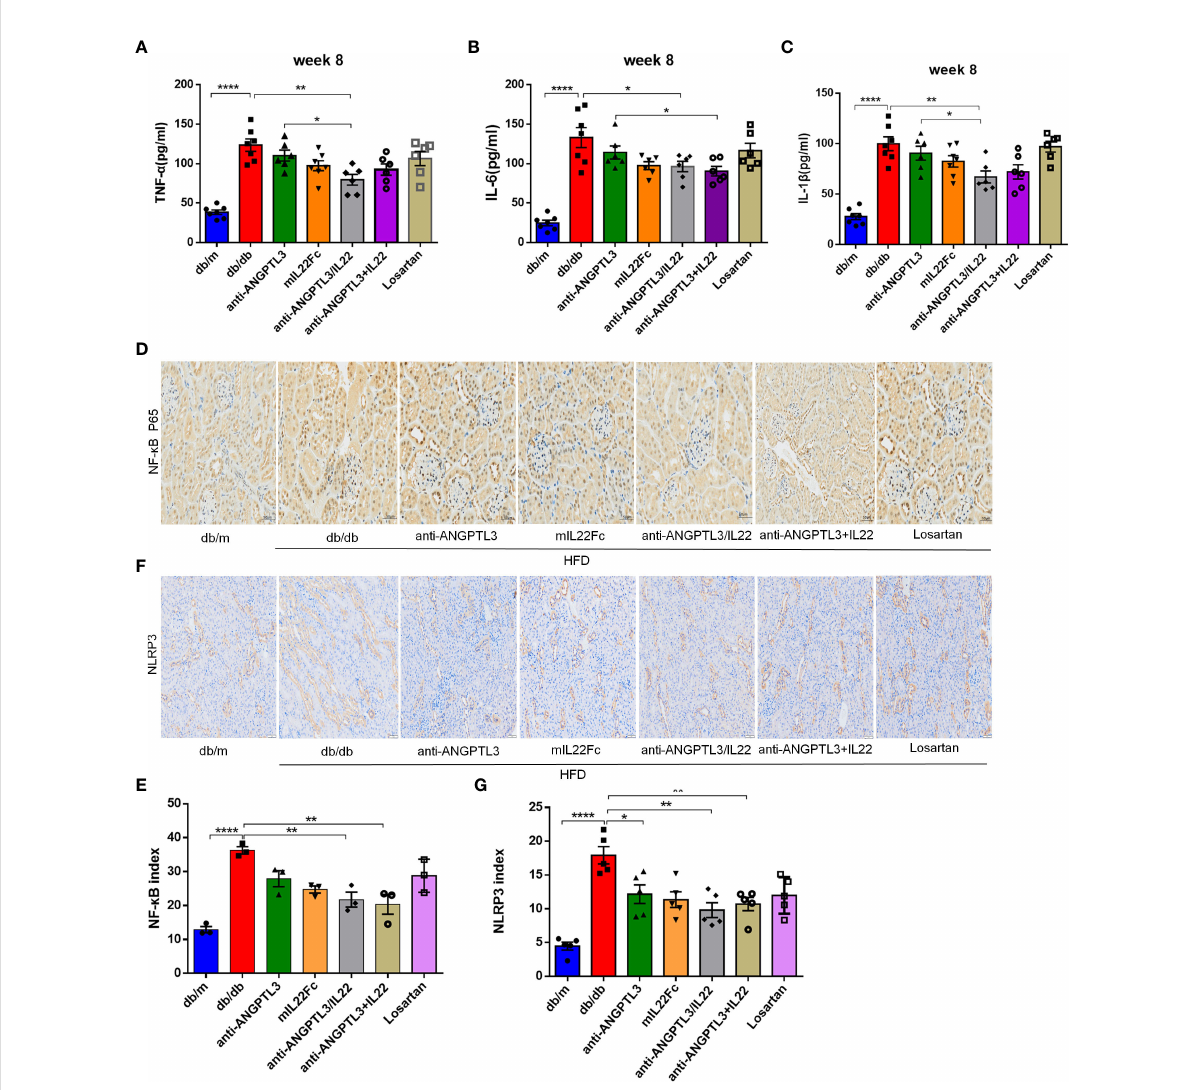
FIGURE 6 Anti-ANGPTL3/IL22 fusion protein attenuated the in fl ammatory response in db/db mice. (A-C) Measurements of serum in fl ammatory factors including TNF- a , IL-1 b and IL-6 in db/db mice after treatment with anti-ANGPTL3/IL22. (D) Representative immunohistochemical images of NF- k B p65 in the kidney sections. (Scale bar: 20 m m). (E) Representative immunohistochemical images of NLRP3 in fl ammasome in the kidney sections. (Scale bar: 50 m m). (F) Quantitative analysis of NF- k B. (n = 3). (G) Quantitative analysis of NLRP3 in fl ammasome (n = 5). * P < 0.05; ** P < 0.01; **** P <